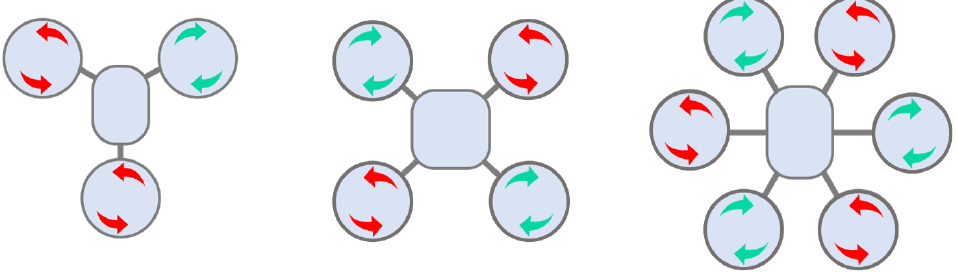
Figure 1. Various layouts of multirotor UAVs.